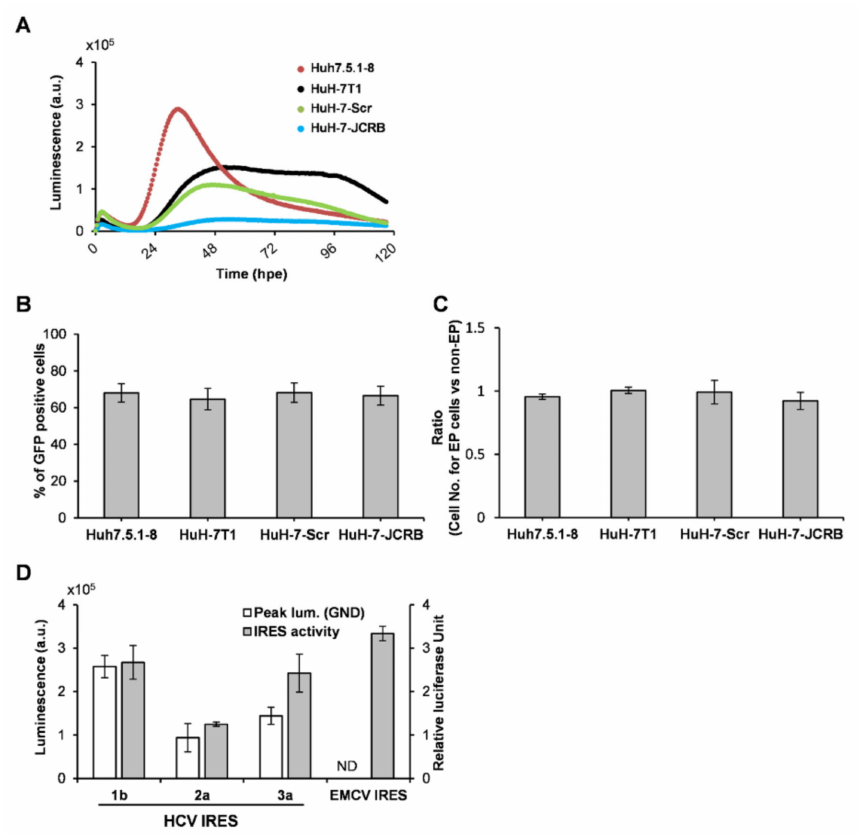
Figure 4. ( A ) HCV replication in several HuH-7-derived cell lines. Huh7.5.1-8, HuH-7T1, HuH-7-Scr, and HuH-7-JCRB cells were electroporated with SGR-JFH1/WT/SLG RNA. After electroporation, 3 × 10 5 cells were immediately seeded into a 35 mm dish for real time monitoring. Luciferase activity was chronologically recorded by Kronos Dio. ( B ) Efficiency of RNA electroporation into each cell line. As indicated in Supplementary Figure S3, the percentages of GFP-positive cells in cells electroporated with GFP RNA were determined by flow cytometry. Each bar graph is represented from triplicate measurements (means with SD) for each cell line. ( C ) Effect of RNA electroporation on cell viability in each cell line. The numbers of cells with or without RNA electroporation were counted after 2 days of culture. Cell viability was expressed as the ratio of the number of electroporated cells to the number of cells without RNA electroporation (means with SD, n = 3). ( D ) Huh7.5.1-8 cells were transfected with bicistronic reporter pRL/1b-Luc, pRL/2a-Luc, pRL/3a-Luc or pRL/EMCV-Luc. After 24 h, activities of Firefly luciferase (FL) and Renilla Luciferase (RL) in cell lysates were determined. The ratio of activity of FL to RL was defined as relative luciferase unit (blank bar) and was compared with the luminescence value at the peak of transient translation of GND replicon obtained in the real time monitoring system (gray bar). Results are presented as means with SD ( n = 3). ND; not